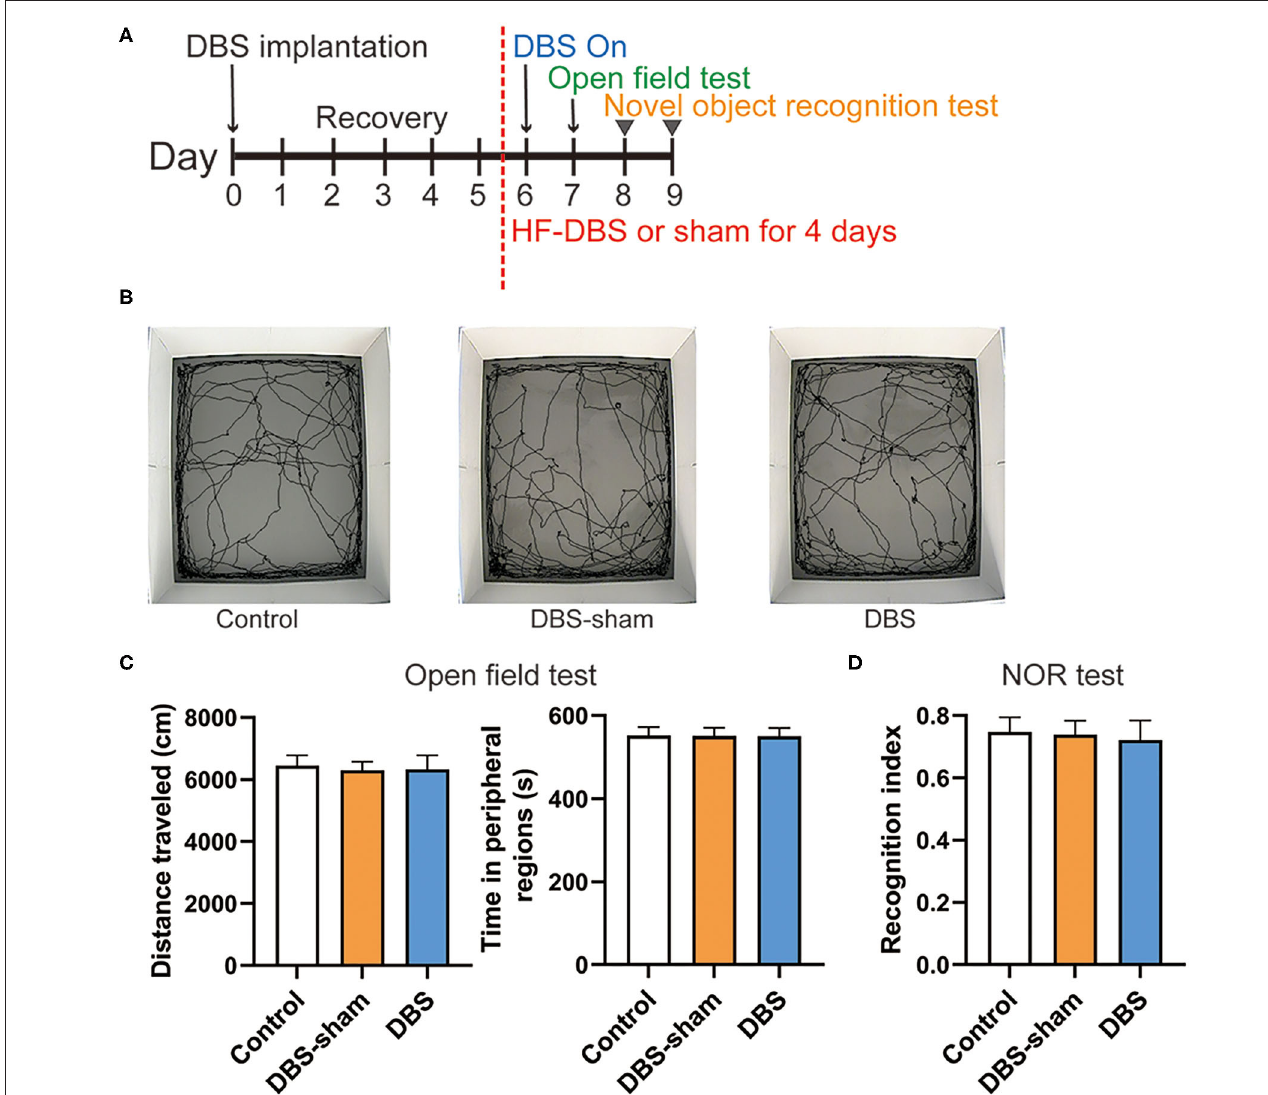
FIGURE 4 | Behavior performance of rats after the continuous high frequency DBS (HF-DBS) stimulus of anterior insula (AI). (A) Experimental scheme. The rats in DBS and DBS-sham groups were bilaterally implanted with DBS electrodes to AI followed by a 5-day recovery. HF-DBS (130Hz, 150 µ A, 90 µ s) was continuously applied in DBS-rats between day 6 and 9. The open field test was performed on day 7 followed by the novel object recognition (NOR) test on day 8 and 9. (B) Representative track maps of rats from control, DBS-sham and DBS groups in the open field tests. (C) Total traveled distance in the arenas and time spent in the peripheral regions were measured in the open field tests to assess the locomotor activity and anxiety-like behavior, respectively. There were no significant differences among groups on locomotor activity [ F (2, 17) = 0.307, p = 0.740] and in the time spent in the peripheral zones of the open-field arena [ F (2, 17) = 0.022, p = 0.978]. (D) The NOR test was performed to evaluate memory and cognitive functions. The recognition index was calculated by the ratio of time spent exploring the novel object to the total time of both novel and familiar objects. There were no significant differences in the recognition index among control, DBS-sham and DBS groups [ F (2, 17) = 0.355, p = 0.707]. Data are shown as mean with SEM. n = 6 for three